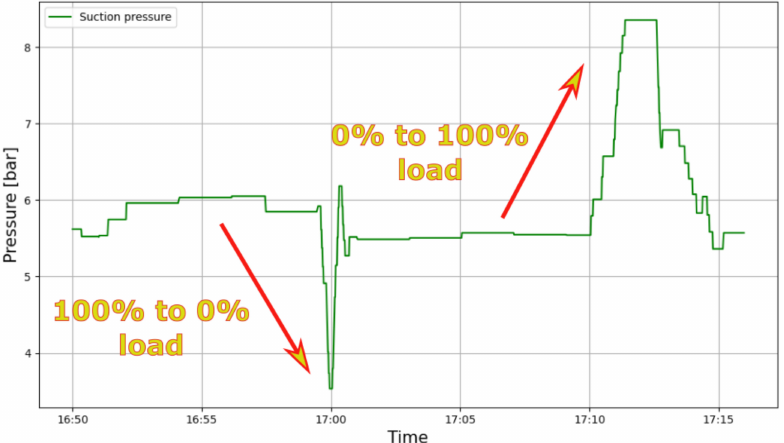
Figure 10. Low pressure compressor reaction to sudden load